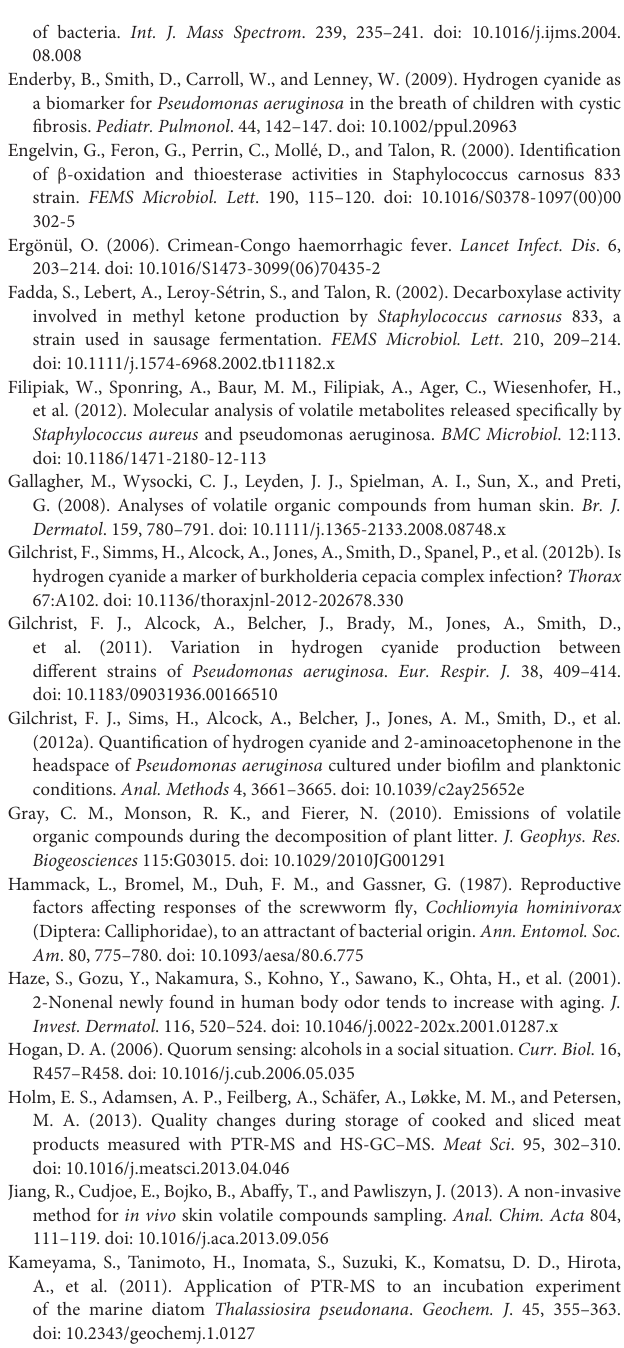
Figure S1 | Chemical standards compared to volatiles from P. aeruginosa PAO1. (A) Chromatograms from chemical standards were collected independently then truncated and overlaid to show retention time. 1-undecene curve is gray to